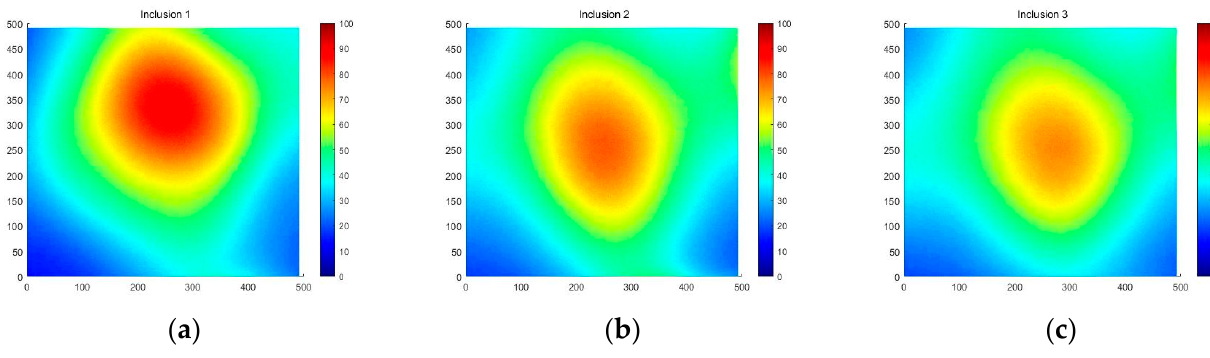
Figure 21. Three-dimensional elastic-image simulation according to the degree of elasticity.